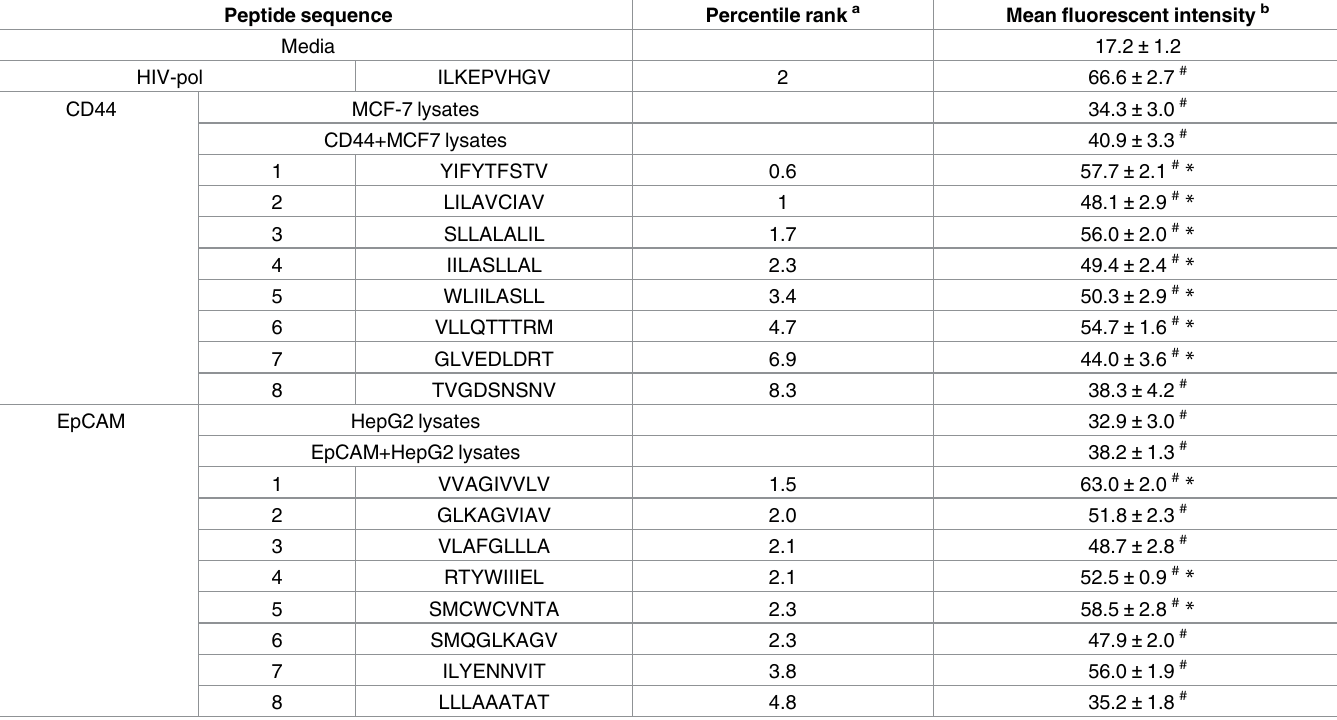
Table 1. Binding affinity of TAA for HLA-A2